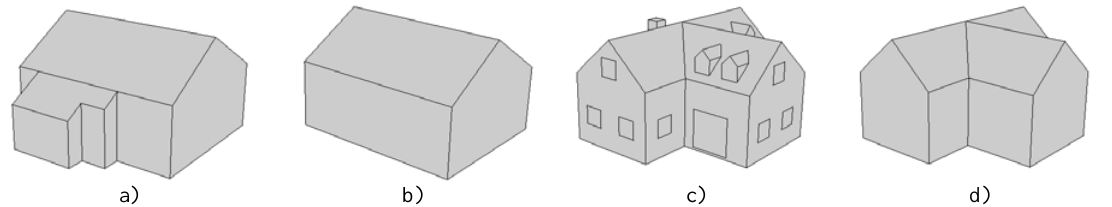
Figure 2. Examples of 3D building models before and after their